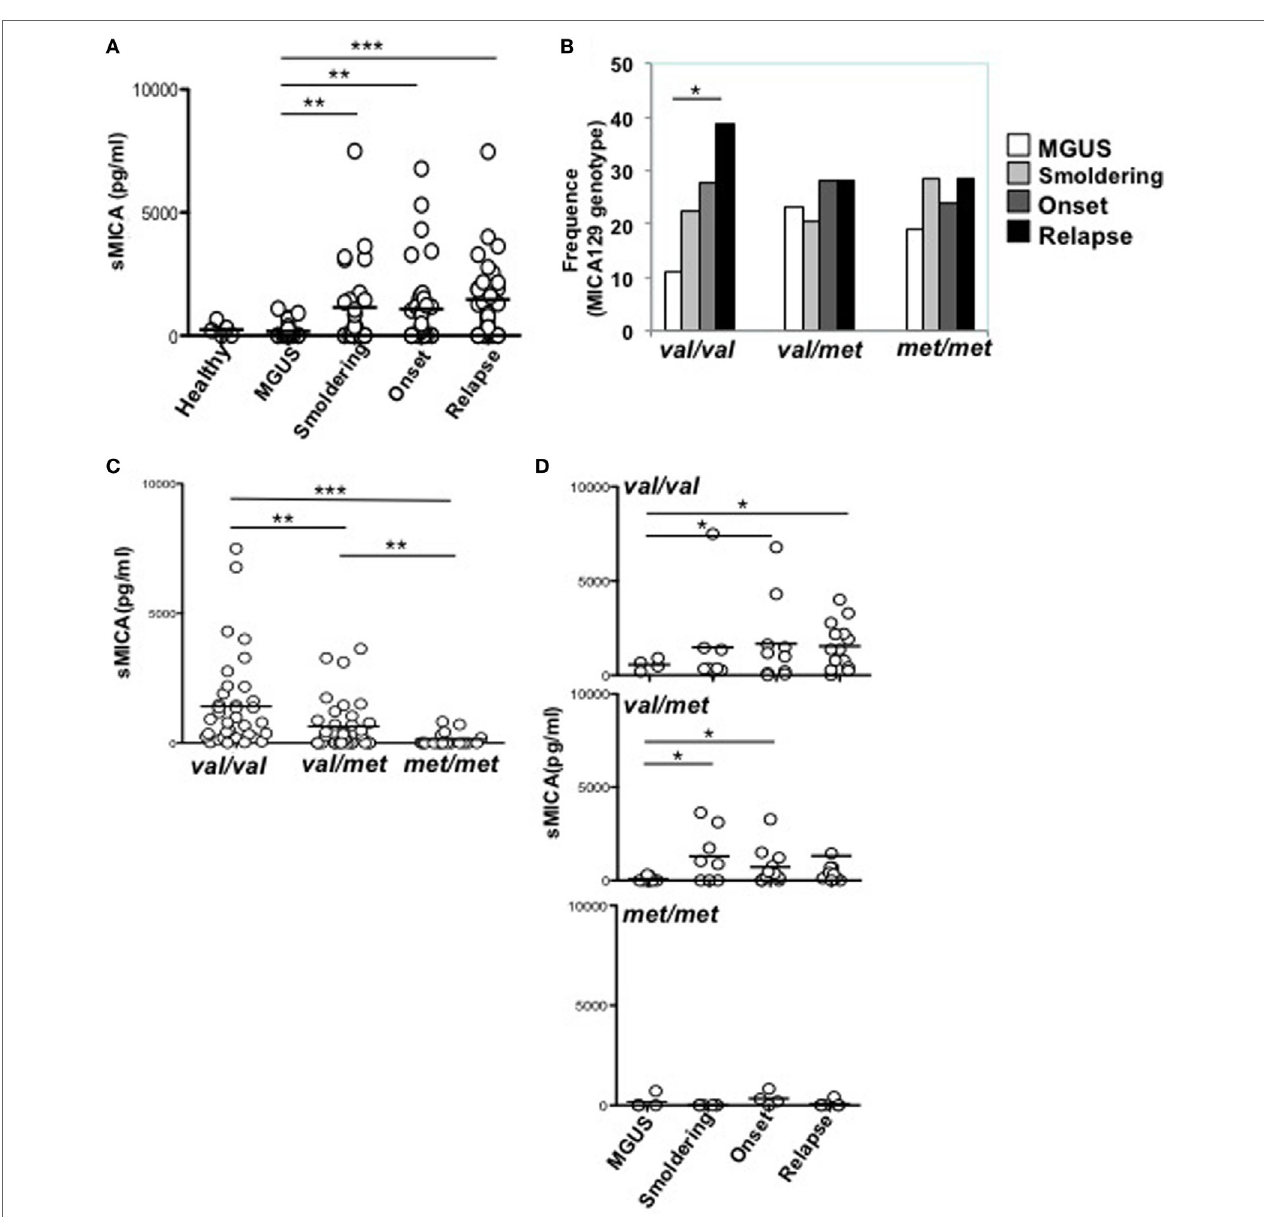
FigUre 1 | MICA-129Val allele is associated with higher amount of sMICA in the sera of multiple myeloma (MM) patients. (a) Sera derived from healthy donors, MGUS, and MM patients at different state disease were analyzed for the presence of soluble MICA through a specific enzyme-linked immunosorbent assay. Total number of patients, 97 (healthy, n = 5, MGUS, n = 16, smoldering, n = 22, onset, n = 26, relapse, n = 32). (B) Frequency distribution of MICA-129 genotypes among different MM disease states. χ 2 test with n − 1 degrees of freedom was performed . (c,D) sMICA is associated with the presence of the MICA-129 valine ( Val ) allele in MM patients. Total number of patients analyzed, n = 91 (Val/Val, n = 37; Val/Met, n = 36; Met/Met, n =